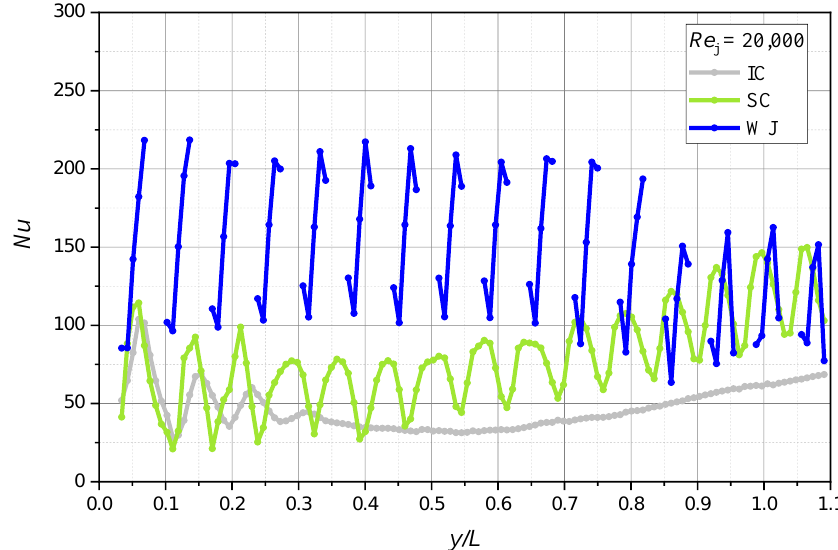
Figure 21. Heat transfer coefficient distribution at the stagnation line of the target surfaces ( Re j = 20,000).